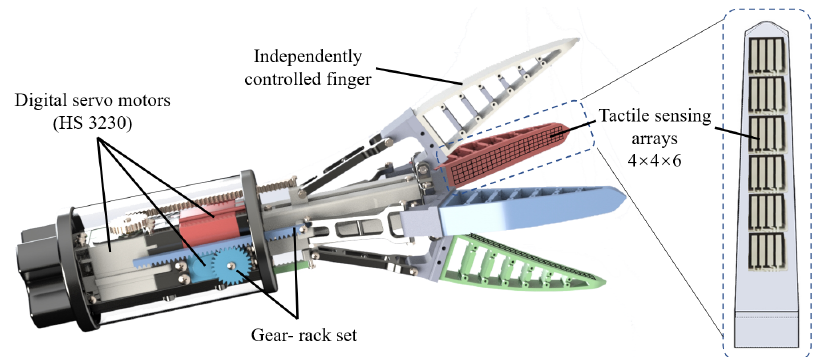
Figure 3. Gripper with independent motor-controlled